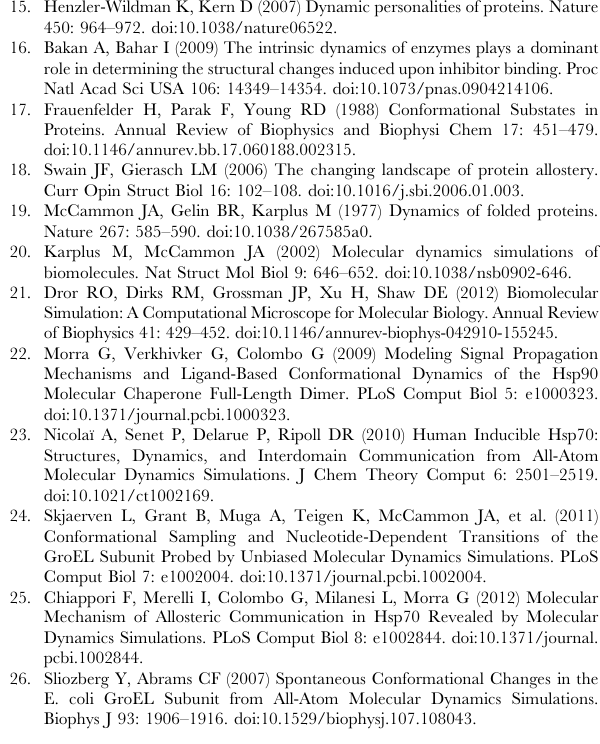
Figure S10 Convergence analysis of MD trajectories. A: C a RMSD with respect to the initial structure computed for the MD runs APO1 (red), ADP1 (blue) and ATP1 (green) up to 250 ns. B: Variance s of the C a RMSD with respect to the initial structure computed for the MD runs APO1 (red), ADP1 (blue) and ATP1 (green) on time windows of 10 ns and up to 250 ns. (EPS) Figure S11 Pathway of minimum energy (PME) for the transition A 1 R A 2 . A: FES generated for the MD run ATP1 from dPCA. Minima are shown with grey diamonds. The PME is shown with black cross and a red line. Interpolated lines d (dashed blue lines) and perpendicular lines p (dot-dashed green lines) are shown for the first three steps only. Empty black squares show the intersection between d and p . B: Free-energy profile V PME along the PME shown in panel A. Table S1 Sequence alignment of human and E. coli Hsp70 s from BLASTp program. Identities are shown in bold and positives in italic. Residues of E. coli Hsp70 relevant for interdomain communication and extracted from the FEL analysis are